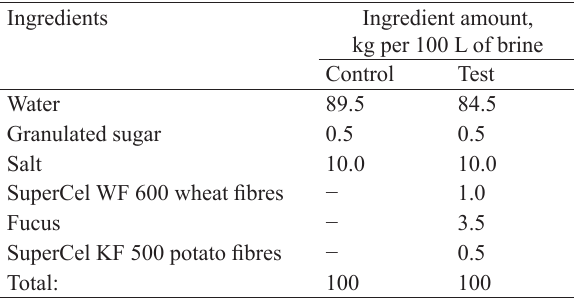
Figure 4 Sensory evaluation of restructured poultry